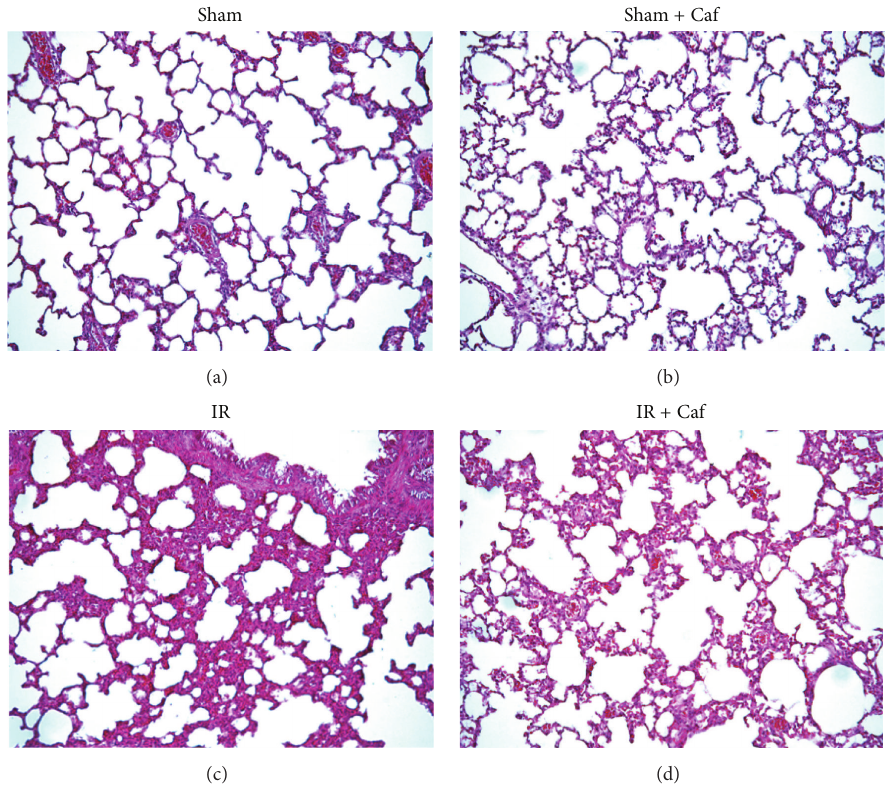
Figure 1: Representative microscopic findings of the lung tissues stained with hemotoxylin & eosin (100x). (a) The sham-operation (Sham) group revealed normal to mild lung inflammation characteristics. (b) The sham plus caffeine (Sham + Caf) group revealed normal to mild lung inflammation characteristics. (c) The lower limb ischemia-reperfusion (IR) group revealed severe lung inflammation characteristics. (d) The IR plus caffeine (IR + Caf) group revealed mild to moderate lung inflammation characteristics. Rats of the Sham + Caf and the IR + Caf groups received caffeine (50 mg/kg, intraperitoneal injection) immediately after reperfusion. To control the effects of vehicle, rats of the Sham and the IR group received normal saline (1.0mL, intraperitoneal injection) at comparable time point.